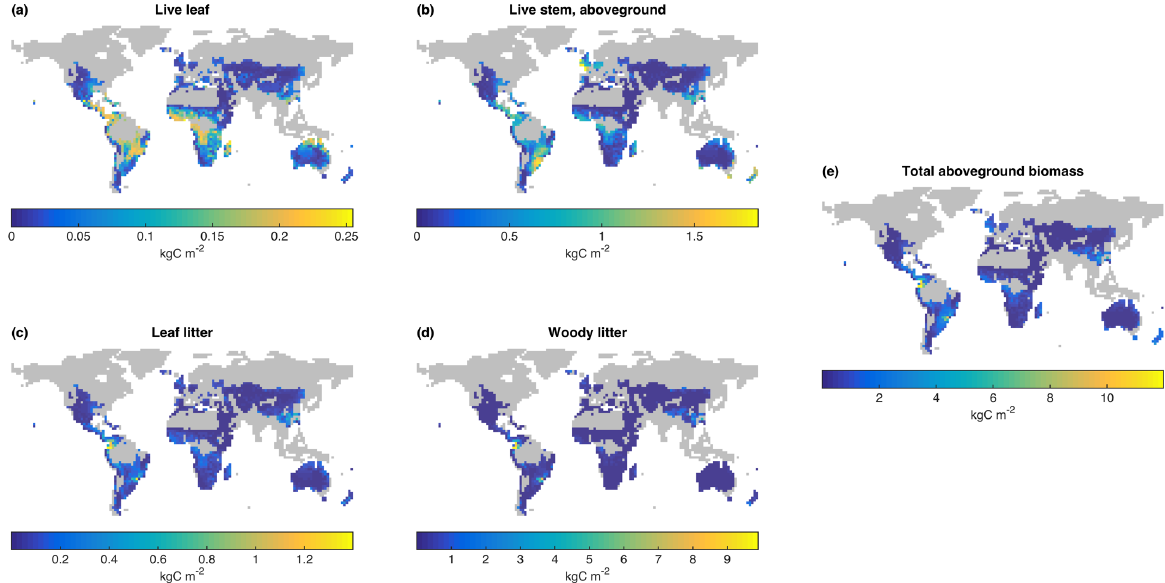
Figure A4. Mean aboveground carbon pools on pasture over 2001–2009. Grid cells composed of < 20% pasture are shown in gray; note that color scales differ between sub-figures. (a) : live leaves; (b) : aboveground live stem; (c) : leaf litter; (d) : woody litter; (e) : total aboveground